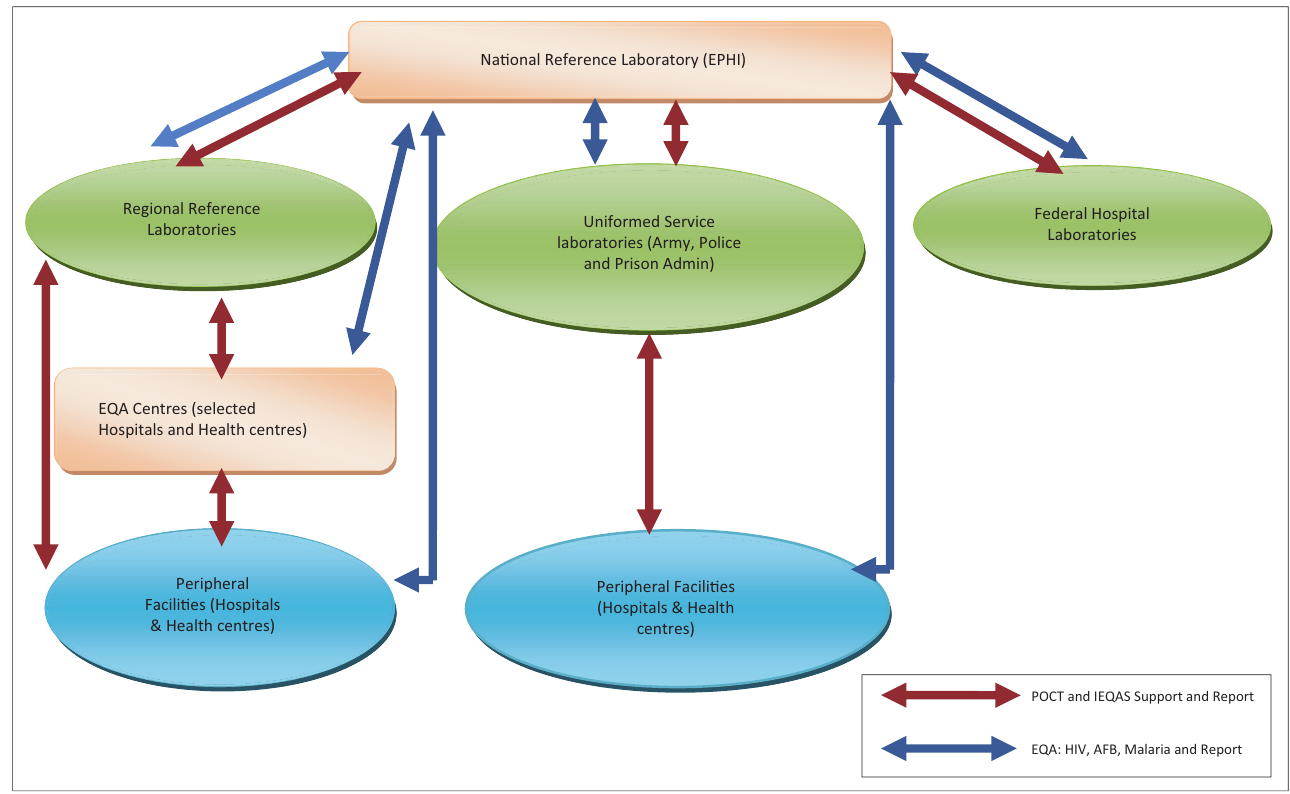
FIGURE 2: Quality assurance framework.